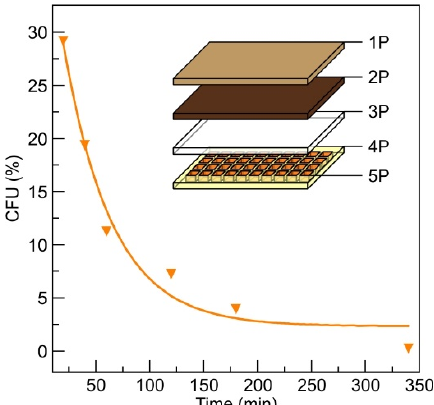
Figure 3. The antimicrobial results of a patch prototype using referential S. aureus bacteria of 0.5 Mf. The prepared prototype was soaked in thermostated bacteria suspension at 35 °C temperature. The fit parameters of the exponential curve are provided in Supplementary Table S2. The inset depicts the structure of the patch prototype that consists of the sticky medical film (1P), the synthetic silk coated with DLC:Ag film (2P), cellulose layer (3P), silicon honeycomb carrier structure (4P), gelatin / agar mixture in honeycomb cavities (SIAL) (5P).